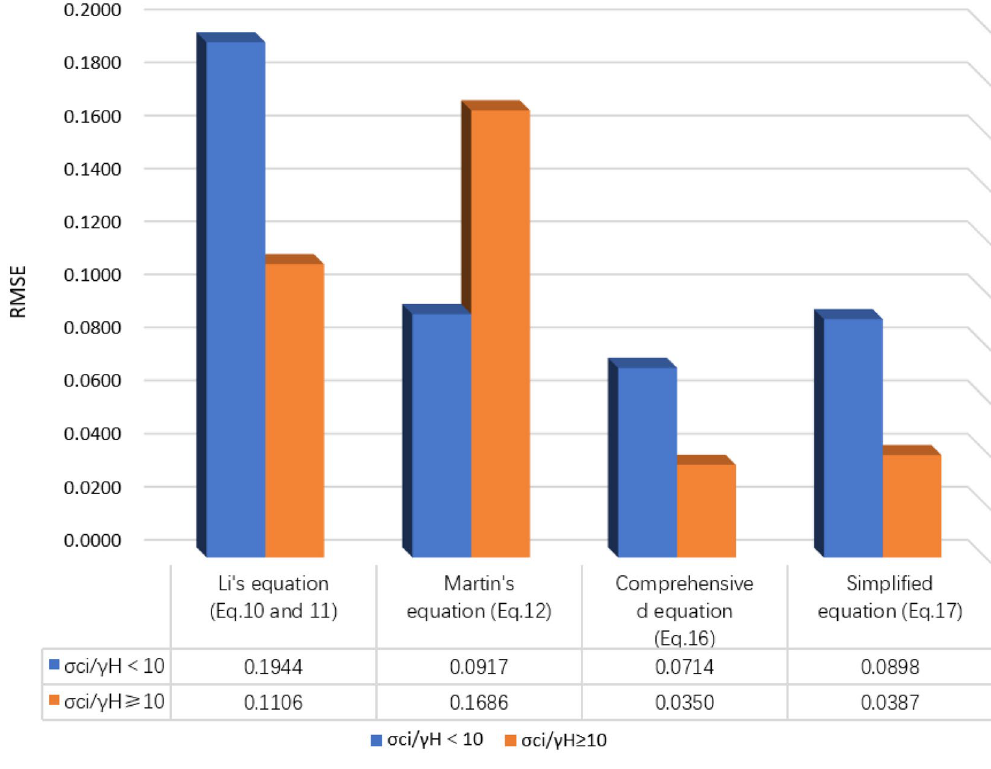
σ ′ 3,max γ H value by different